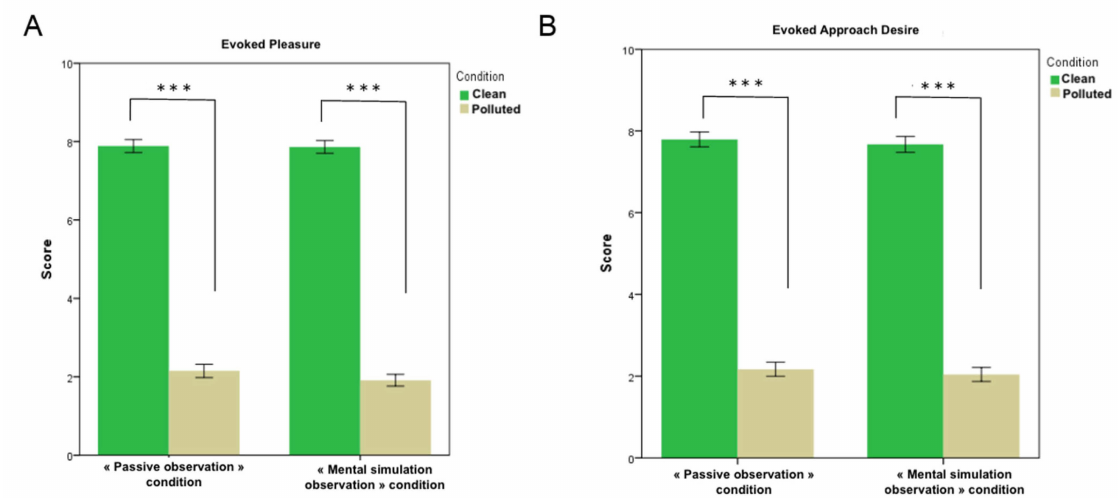
Figure 2. Mean Evoked Pleasure ( A ) and Evoked Approach Desire ( B ) (mean ± SEM) on 44 images (22 presenting a polluted environment and 22 presenting a clean environment) according to Passive observation condition (left side of each panel) and Mental simulation observation condition (right side of each panel). Statistical differences are shown as *** p <